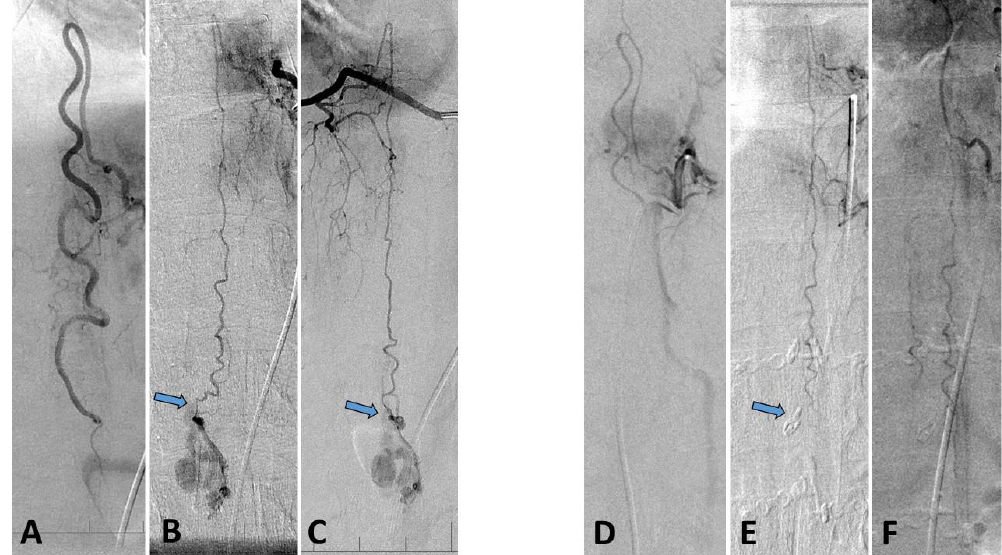
Figure 4. Spinal digital subtraction angiography after neurological deterioration. ( A – C ) Preoperative and ( D – F ) postoperative findings. ( A ) Spontaneous occlusion of the pedicle feeding the PMAVF from the dilated anterior spinal artery (ASA). ( B ) Left posterior spinal artery (LPSA) supplying the PMAVF (arrow—point of shunting). ( C ) Right posterior spinal artery (RPSA) supplying the AVF (arrow—point of shunting). ( D ) Normalized flow in the ASA after surgical fistula occlusion. ( E ) LPSA after surgery, note the clip at the fistula location (arrow). ( F ) RPSA after surgery.